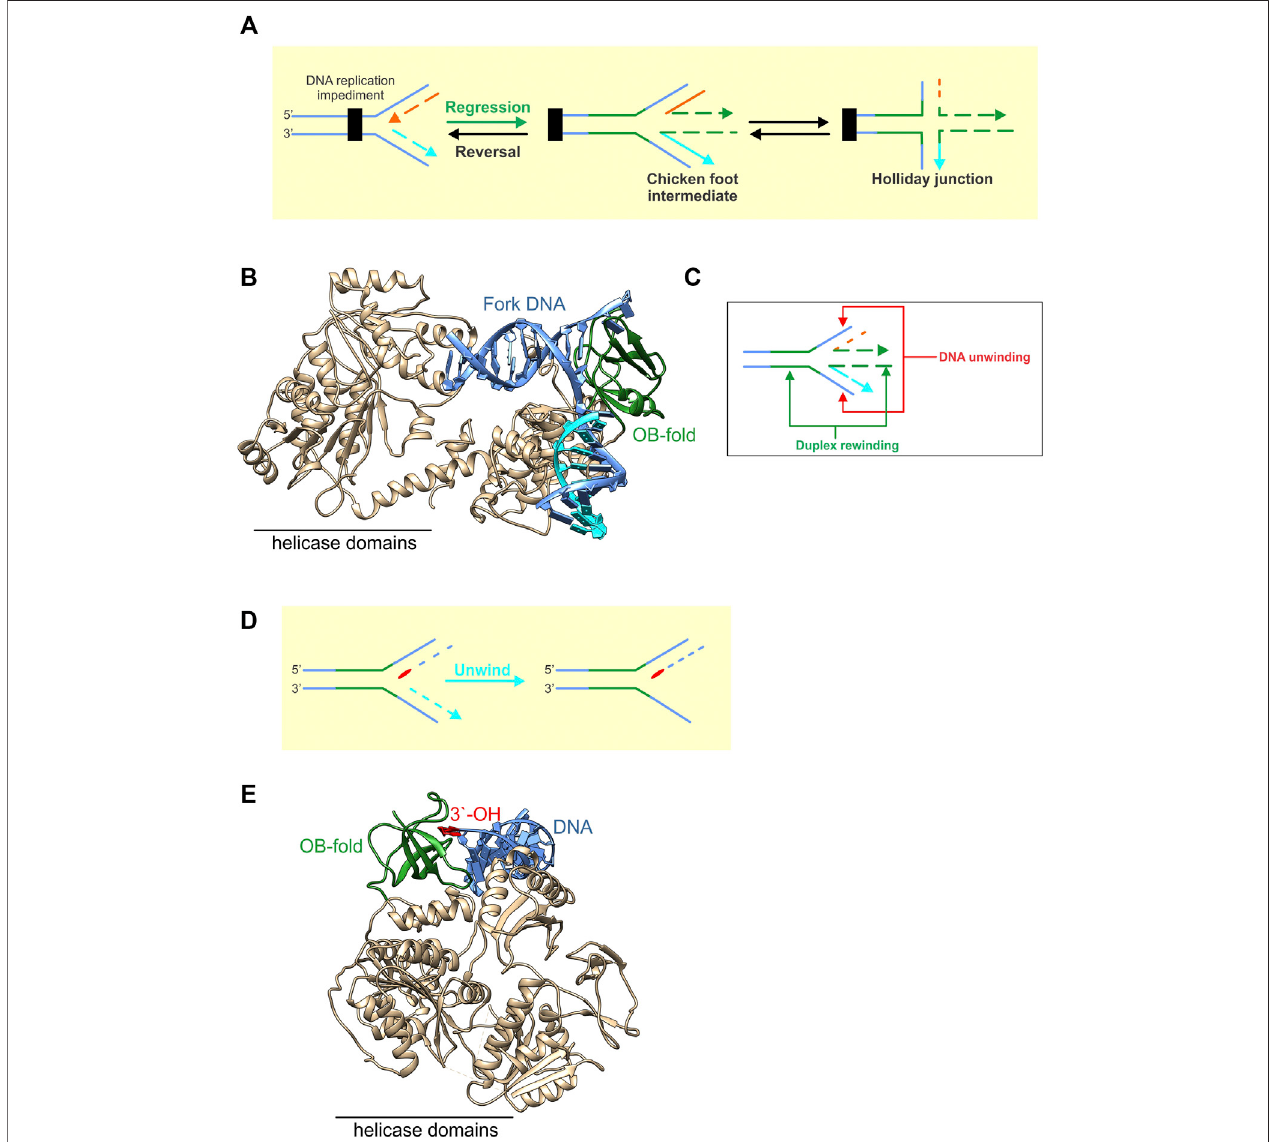
FIGURE7| OB-foldsinforkrescuehelicasesareusedindifferentwaystomodifyforkstructures. (A) RecGcatalyzesforkregression,whichisthenetmovementof the fork in a backward direction away from the site of a fork impediment. This results in the formation of a chicken foot intermediate or Holliday Junction. (B) RecG is shown as a ribbon diagram with the OB-fold coloured green and the remainder of the protein including the helicase domains, coloured neutral (PDB fi le 1GM5). The enzymeisboundtoaforkwithagapinthenascentleadingstrand.ATPhydrolysisbythehelicasedomainsisusedtopushtheOB-foldthroughthefork.Thisresults inthecoupling oftheunwindingofthenascentforkarms totherewindingofDNAduplex both inthewakeofadvancingenzymeaswellasaheadoftheOB-foldashown in the schematic in panel (C) . (D) PriA is shown bound to the leading strand arm of the fork (PDB fi le 6DGD). Here it utilizes its OB-fold (coloured green) to bind to the 3 ′ - OH group (red) positioned at the fork with high af fi nity. This enables PriA to unwind the nascent lagging strand arm of the fork (light blue) so that the replicative helicase DnaB can be loaded onto the exposed ssDNA of the template lagging strand as shown in the schematic in panel E.